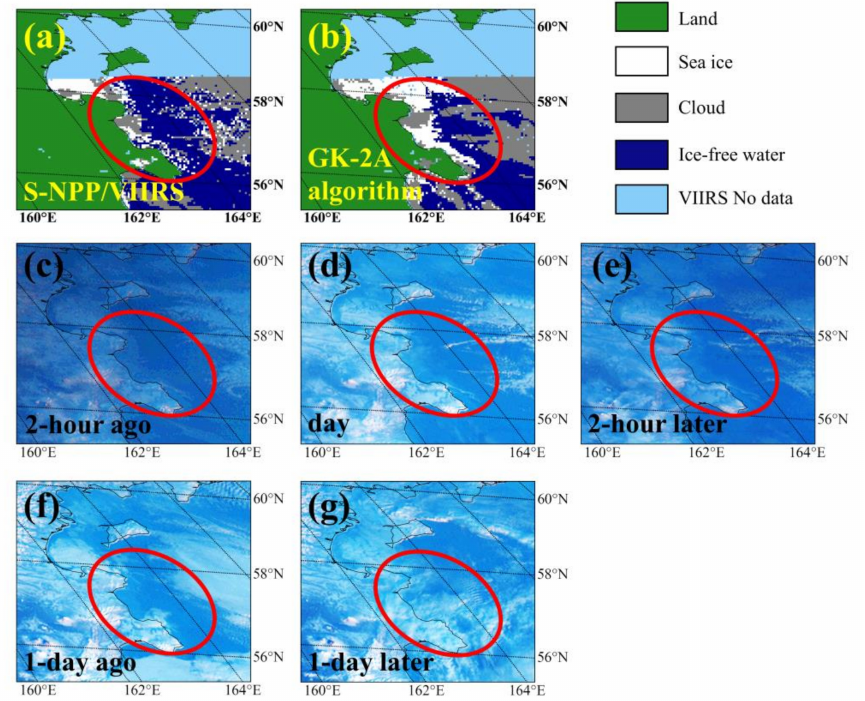
Figure 11. ( a ) S-NPP / VIIRS SIC EDR data at 00:26 UTC, 16 January 2018, ( b ) sea-ice data using GK-2A / AMI sea-ice detection algorithm at 00:30 UTC, 16 January 2018, ( c ) Himawari-8 / AHI RGB image at 22:30 UTC, 15 January 2018, ( d ) Himawari-8 / AHI RGB image at 00:30 UTC, 16 January 2018, ( e ) Himawari-8 / AHI RGB image at 02:30 UTC, 15 January 2018, ( f ) Himawari-8 / AHI RGB image at 00:30 UTC, 15 January 2018 and ( g ) Himawari-8 / AHI RGB image at 00:30 UTC, 17 January